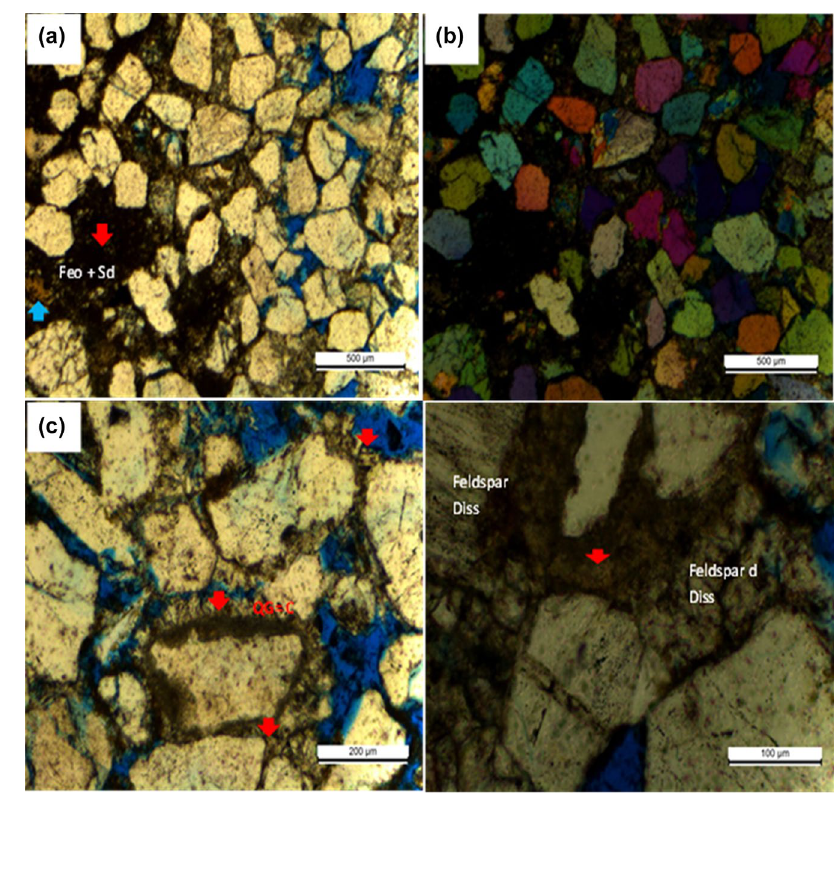
Fig. 5 SEM images of repre- sentative photomicrographs of massive coarse-grained sandstone (MCGS) showing different pore types: ( a ) grain shapes, sorting/packing, ( b ) fine-grained matrix fraction obliterating intergranular pores, ( c ) fracture pore and quartz growth reduces pore, ( d ) quartz growth obliterates intergranular pore space and throat in this